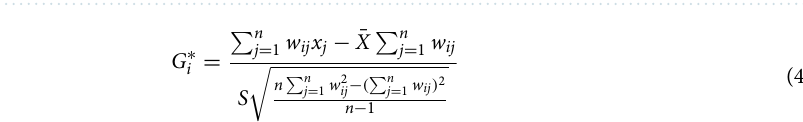
Figure 2. Multivariate kernel density estimations of PM10 and temperature ( a ), humidity ( b ), pressure ( c ), wind speed ( d ), wind azimuth ( e ) on the 11th of